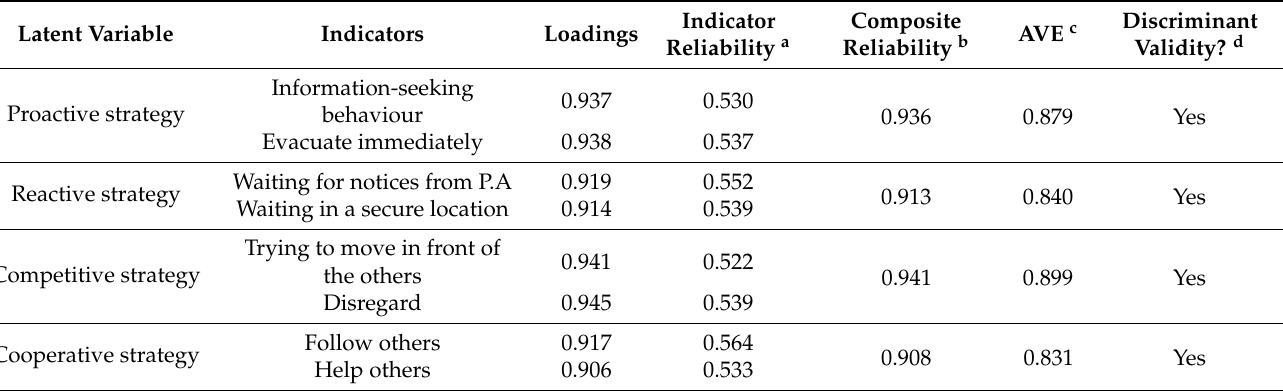
Table 4. Final assessment results of the reflective